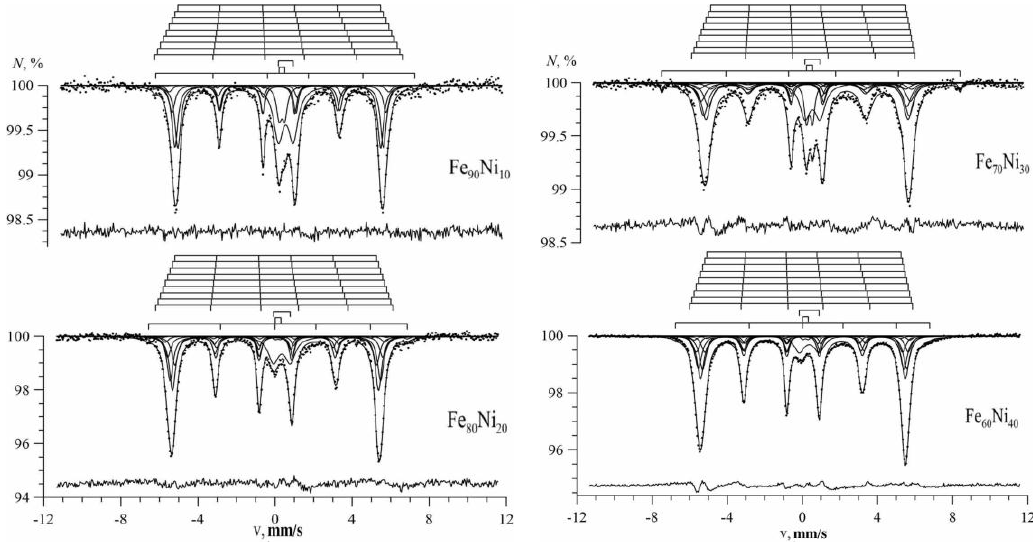
Figure 9. The result of the model decoding of the Mössbauer spectrum of Fe 100-x Ni x nanotubes.